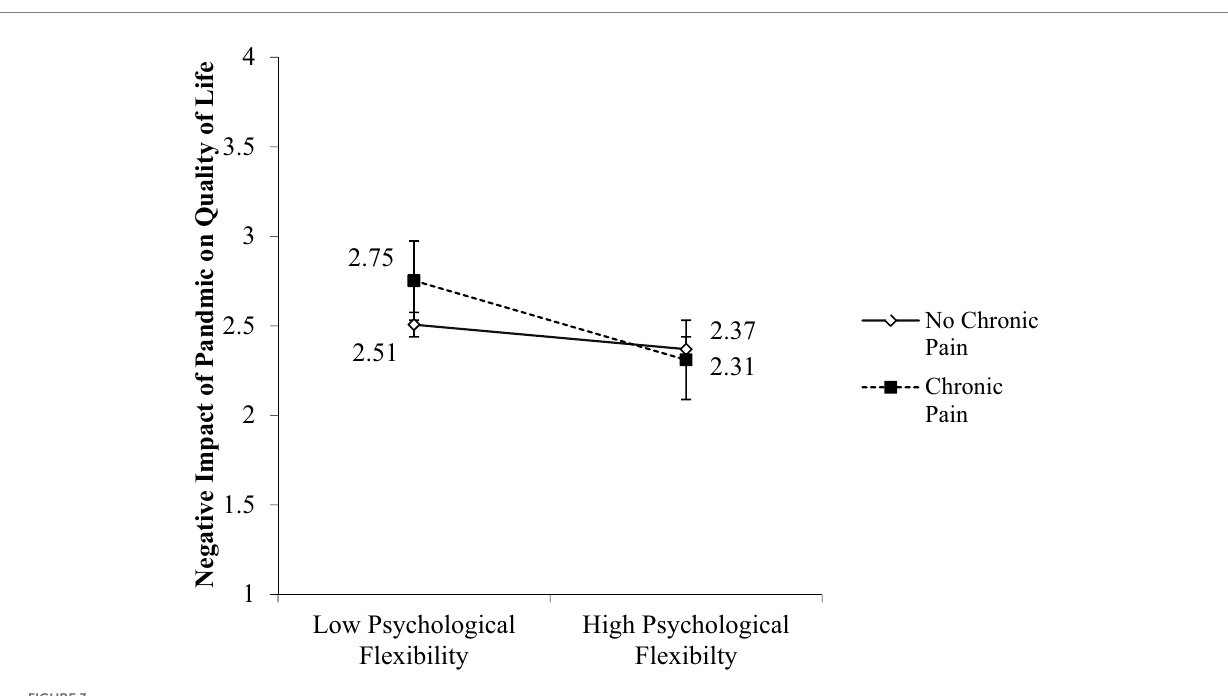
FIGURE 3 Interaction of psychological flexibility and chronic pain on pandemic-related quality of